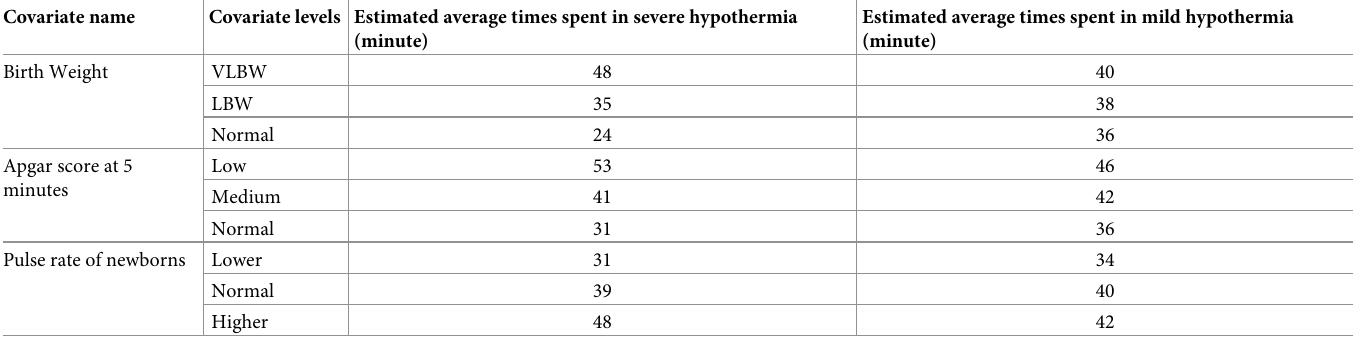
Table 3. Shows the estimated average times spent in severe and mild hypothermia for each group of newborns based on birth weight, Apgar score, and pulse